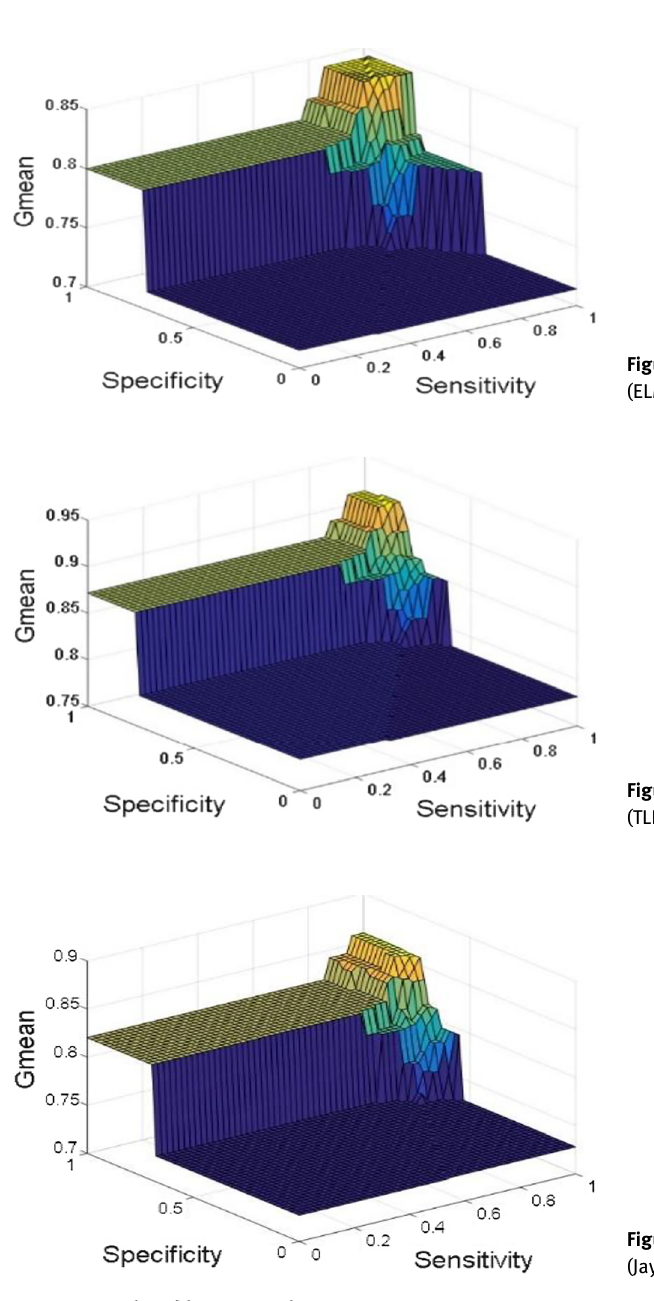
Figure 20: Sensitivity versus specificity versus Gmean (Jaya-ELM).